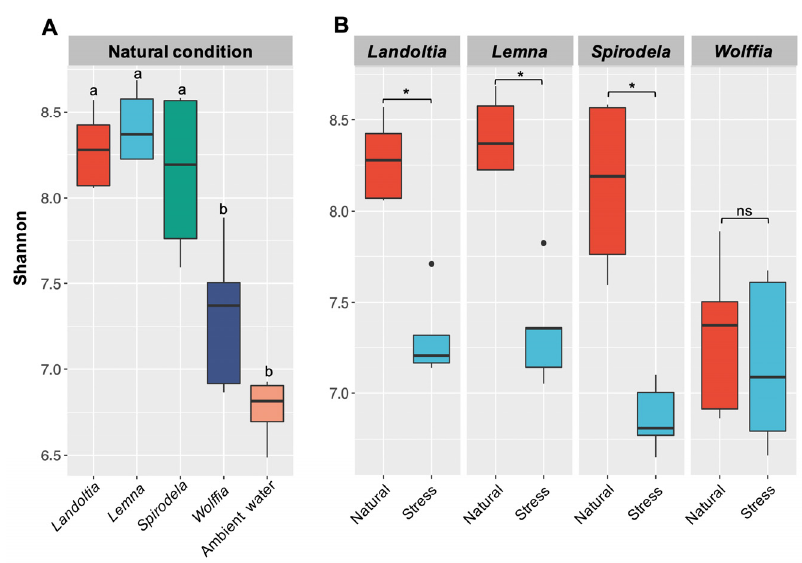
Figure 1. Comparison of alpha diversity index (Shannon). ( A ) Between natural duckweed subtypes and ambient water; and ( B ) between natural and nutrient-deficient (stress) conditions. Asterisks (*) indicate significant difference based on Kruskal-Wallis test, p -value < 0.05; ns, no significant difference.